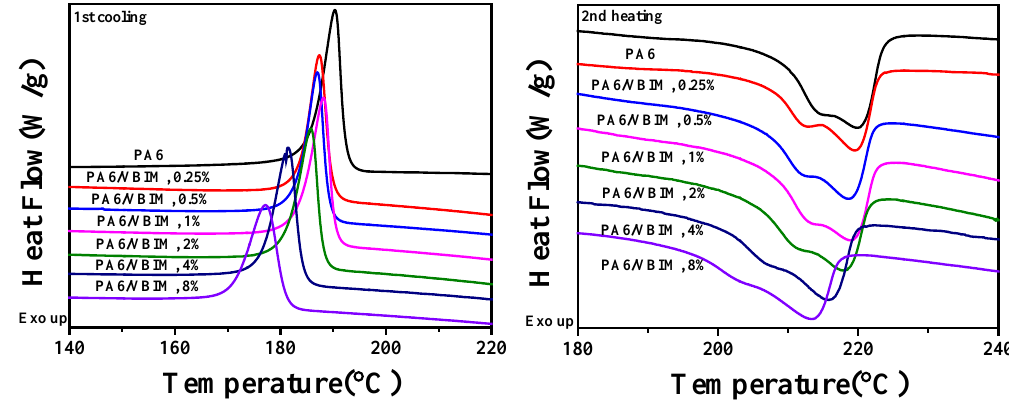
Figure 3. DSC first cooling (after 5 min isothermal for erasing heat history) and second heating curves of PA6 and the PA6/VBIM blends with different VBIM loadings.